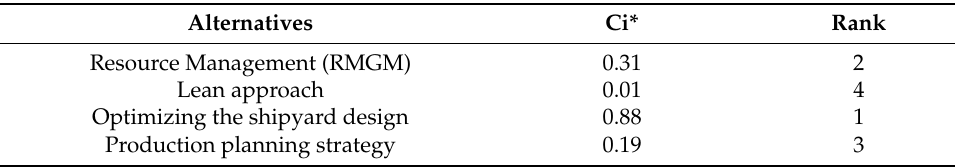
Table 6. Ranking of alternatives in operation criterion.